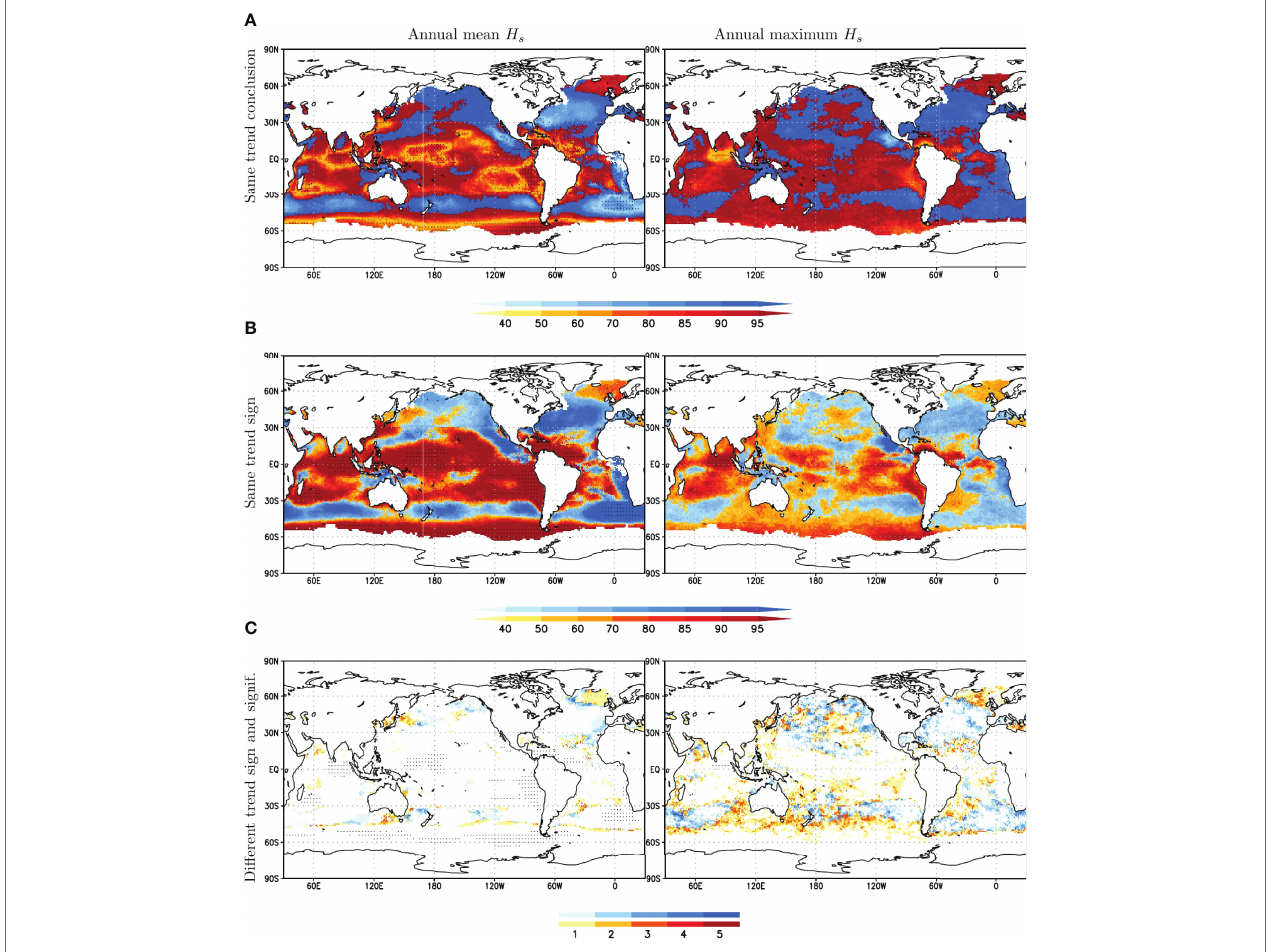
FIGURE 7 | Fraction of ensemble members (%) with the same trend conclusion (A) , the same trend sign (B) and different trend sign that is statistically significant (C) , as compared to the ensemble average for the annual mean H s (left) and the annual maximum H s (right) (see Section 2.2 for more details). Warm(cold) shades indicate the ensemble mean trend is positive(negative). Stippling indicates the ensemble mean trend is statistically